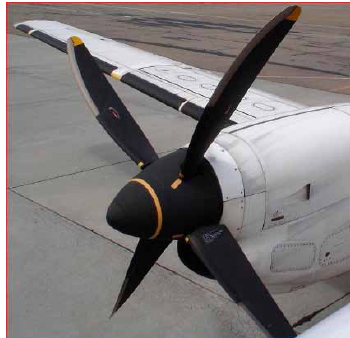
Fig. 6. Propeller in a feathered position